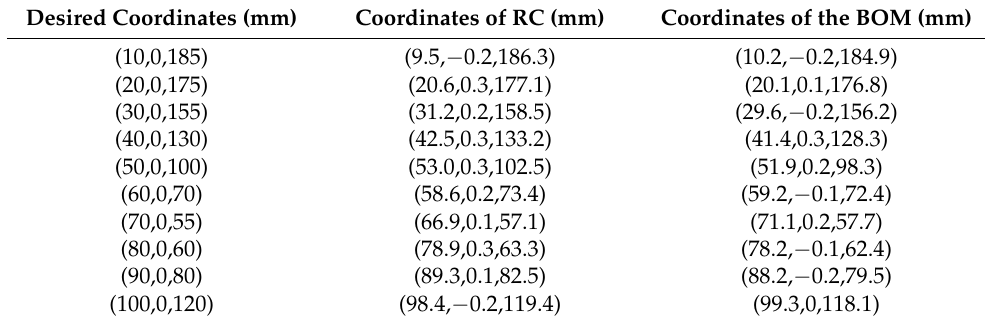
Table A2. The raw data for Figure